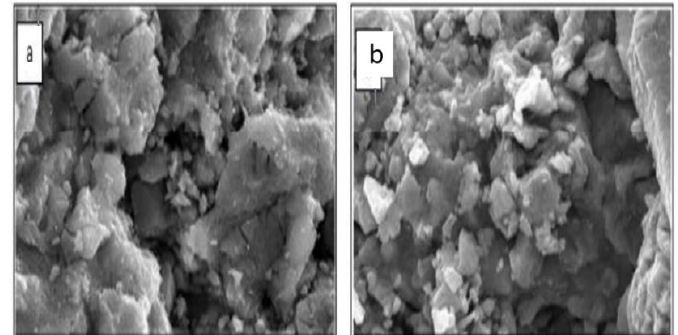
Figure 4. SEM Image of Magnetite synthesized sample. ( a ) stirring rate ( b ) temperature.